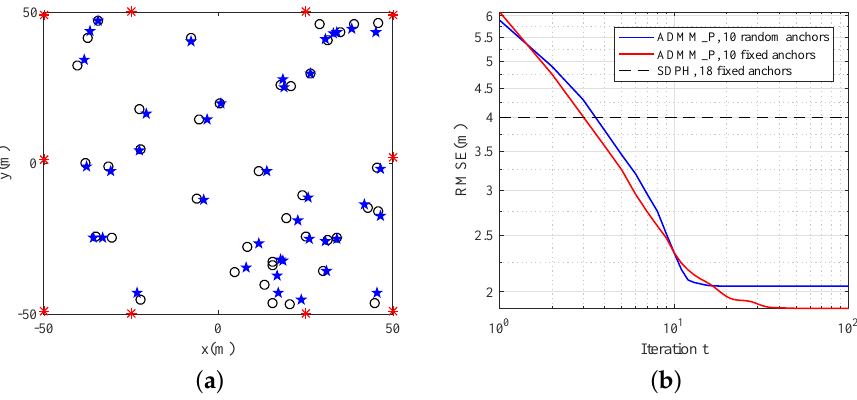
Figure 7. Estimation results of a sensor network with 10 fixed anchors and 40 randomly distributed sensors. ( a ) Estimation locations. Red asterisks *: anchor locations; black circles ◦ : true sensor locations; blue stars (cid:63) : estimation results; ( b ) RMSE comparison.